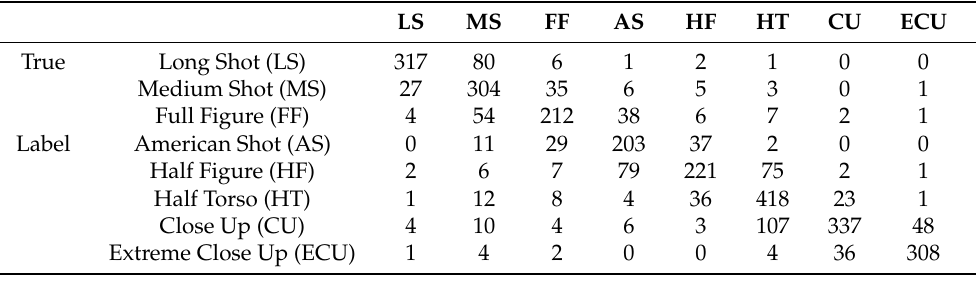
Table 19. Confusion Matrix of the cerberus model VGG-16 trained on the three Datasets.